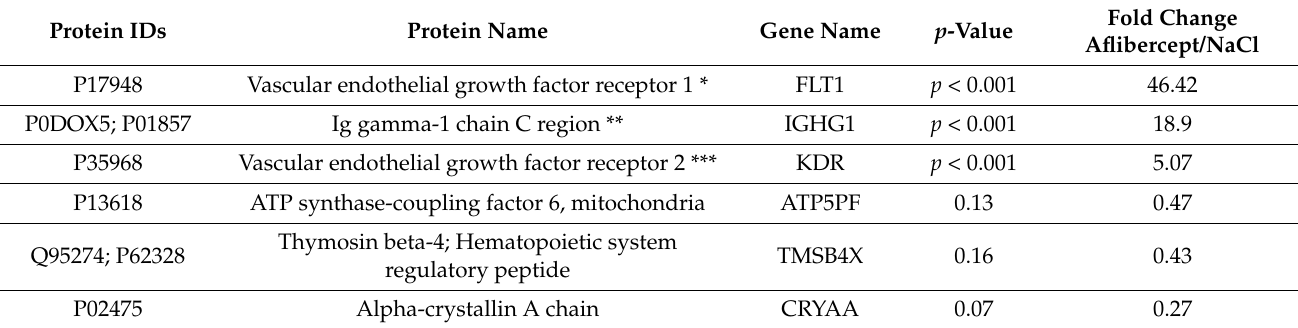
Table 2. Proteins with fold changes >2.0 or